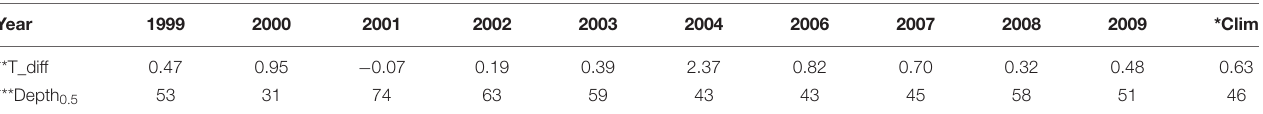
FIGURE 6 | The winter seasonal climatology of (A) temperature and (B) phosphate at depths of 0, 25, 50, 75, and 100 m from WOA18 with a spatial resolution of 0.25 ◦ and 1 ◦ respectively. TABLE 1 | Temperature difference between the surface and the 50 m depth and the depth where the surface temperature is 0.5 ◦ C colder than the